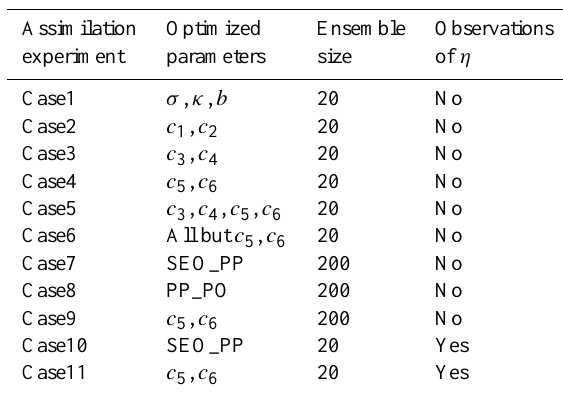
Fig. 6. Power spectra of (a) w and (b) η derived from the truth (red line), SEO (black line), and PP_PO (blue line), respectively. Table 1. Assimilation experiments list in Sect.